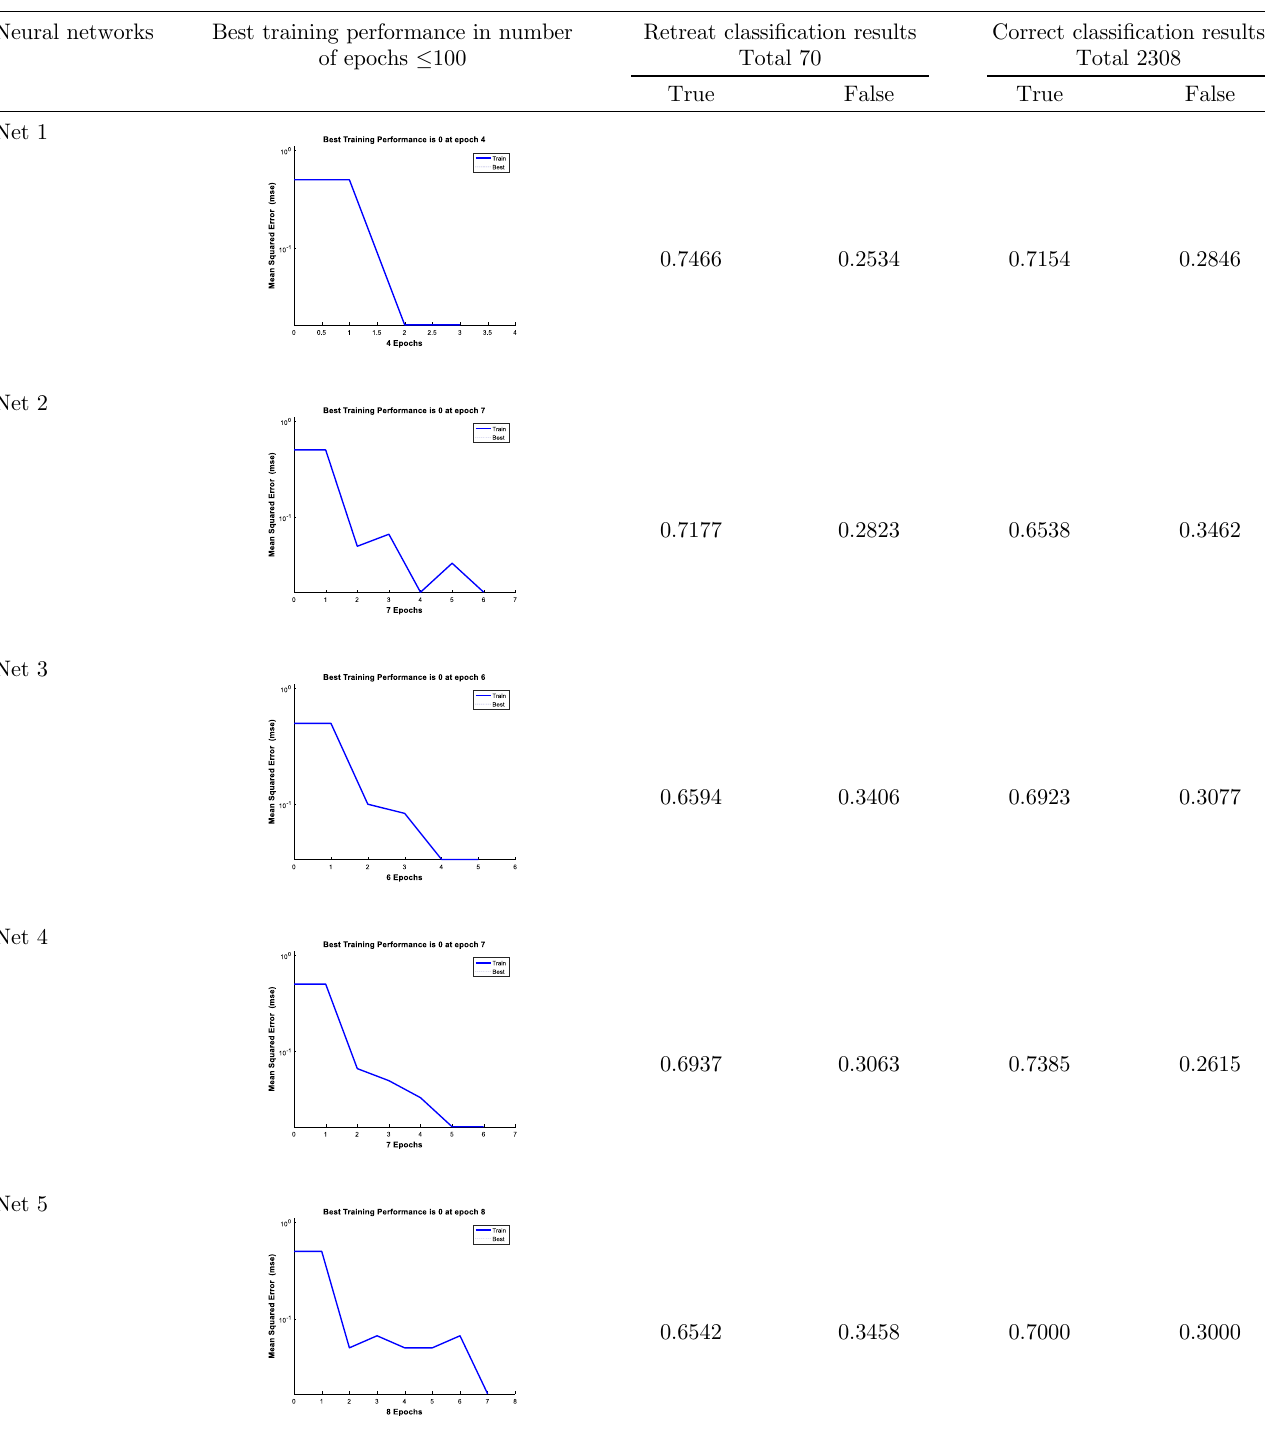
Table 3. Results for a neural network constructed of 78 neurons, following training for (cid:6) 100 epochs (see Eq. (1)). The number of each training vector for both treatment and retreatment groups is 30. Each time, the procedure continues until the mean square error is minimized within the (cid:6) 100 number of epochs. Following the training procedure, two groups ( c -correct case and r -retreat case) of vectors are constructed (see Eq. (9)). The procedure is repeated eight times with randomly constructed training vectors so that eight equivalent but different neural LVQ networks are constructed. The results of the eight repetitions are then averaged to permit a best estimate of the network ’ s